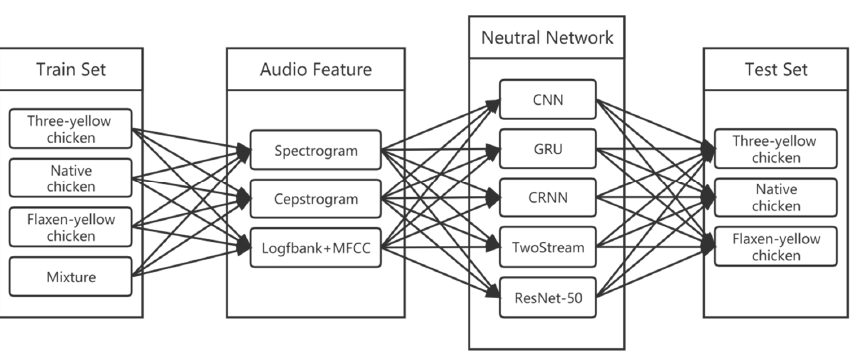
Figure 14. Structure of the cross-comparison experiment.